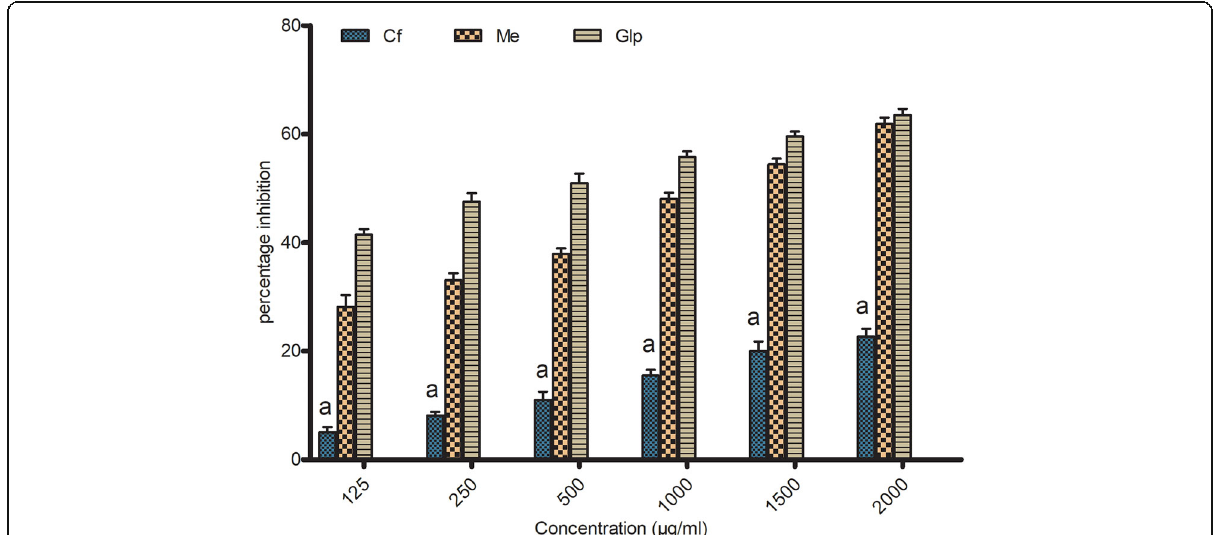
Fig. 4 Antidiabetic potency of methanolic extract of rhizome of Sorghum halepense (L.) Pers and its fractions, Glp: glucophage, Aqf: aqueous fraction, Cf: chloroform fraction, Hf: n -hexane fraction and Me: methanolic extract Asa: ascorbic acid. The scavenging effect of extract and ascorbic acid were compared. a indicates significance at p < 0.001 (Dunnett ’ s-test). (*Aqf: aqueous fraction and Hf: n -hexane fractions lacked antidiabetic properties). Performed the experiments in triplicate ( n = 3)